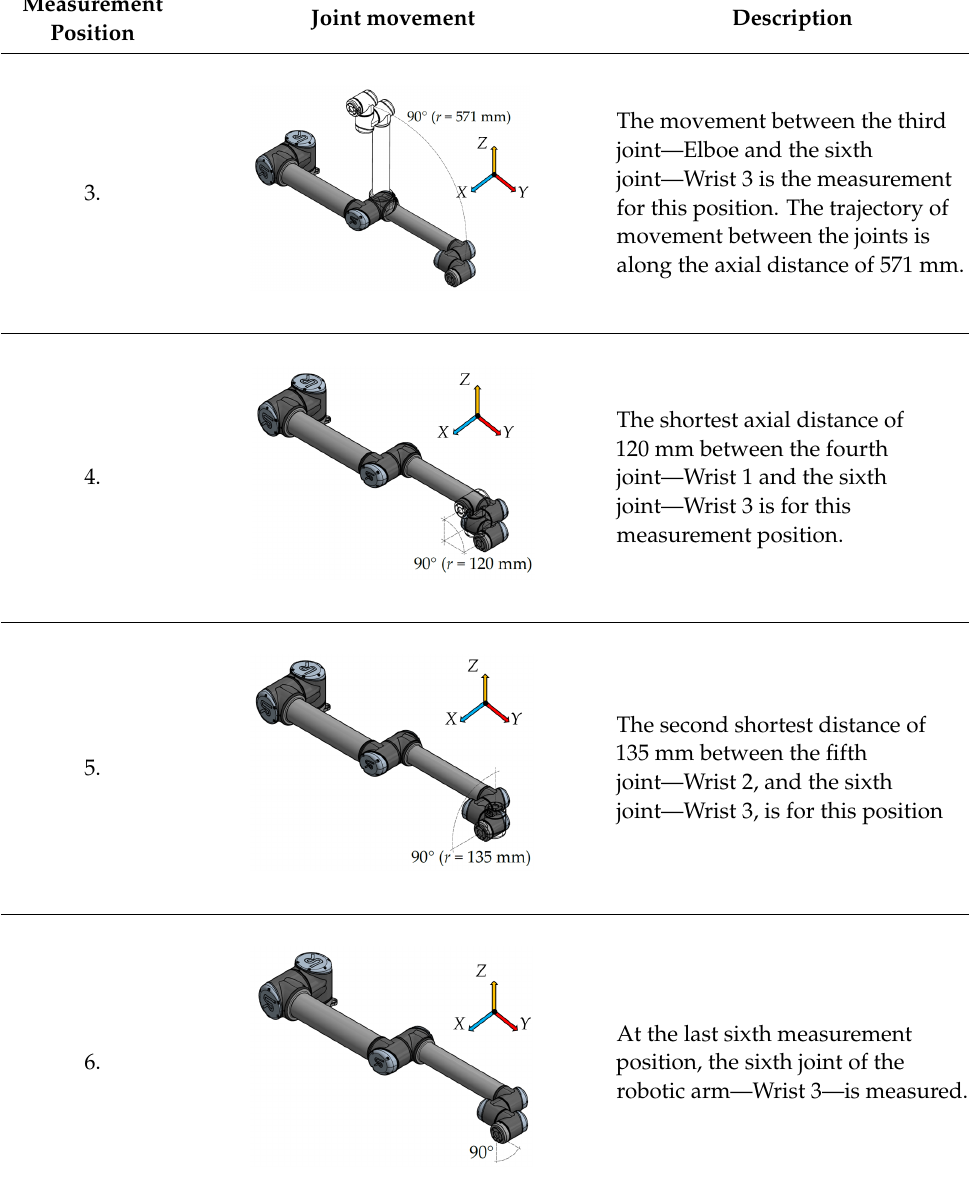
Figure 3. Location of sensors for vibration measurement.